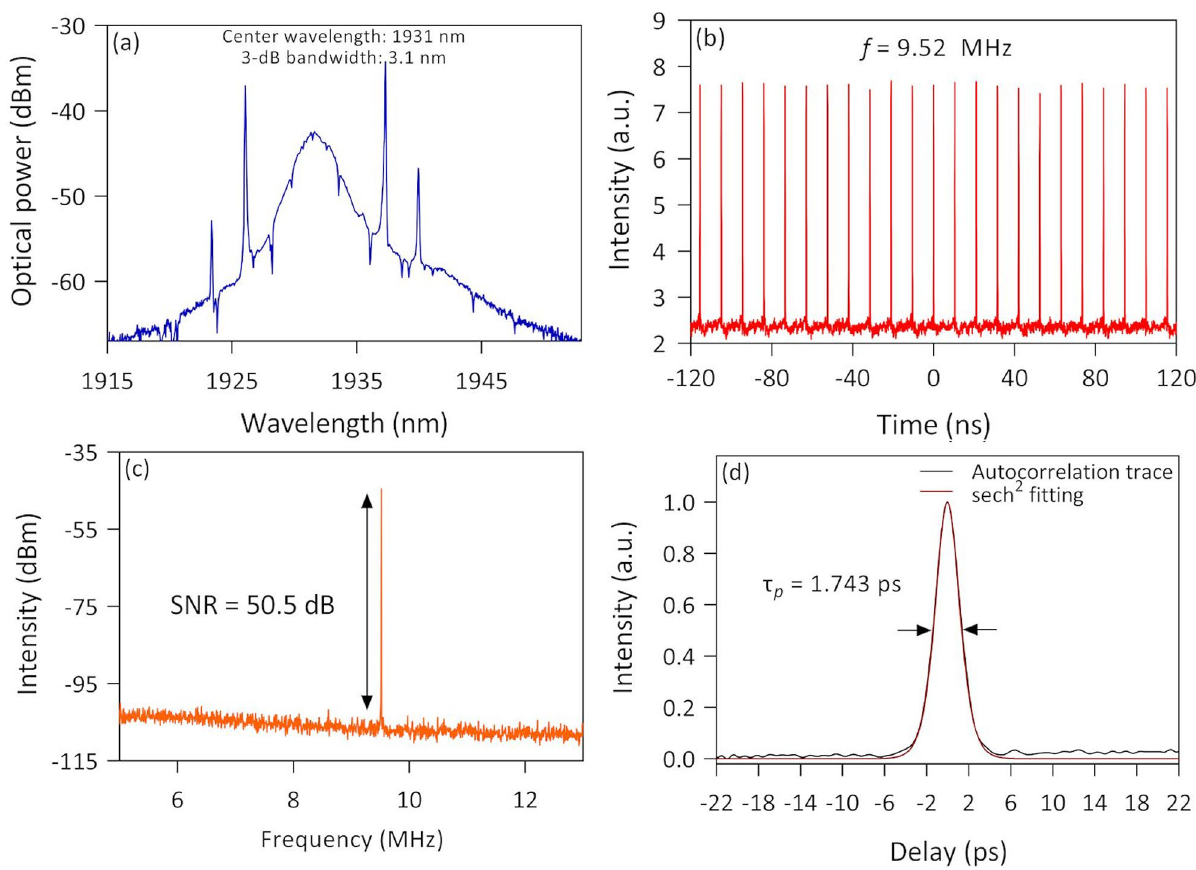
Figure 12. The output characteristic for mode-locked thulium-doped fiber laser using Ta 2 AlC side polished fiber saturable absorber ( a ) optical spectrum, ( b ) pulse train, ( c ) radio frequency spectrum, and ( d ) autocorrelation